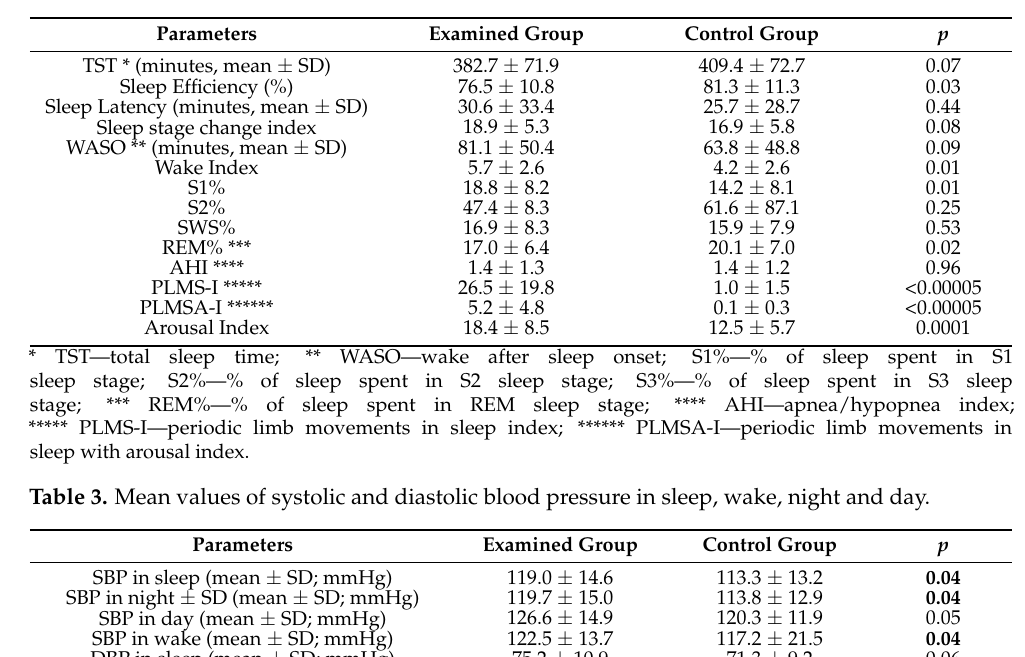
Table 2. Sleep parameters of the examined and control groups.